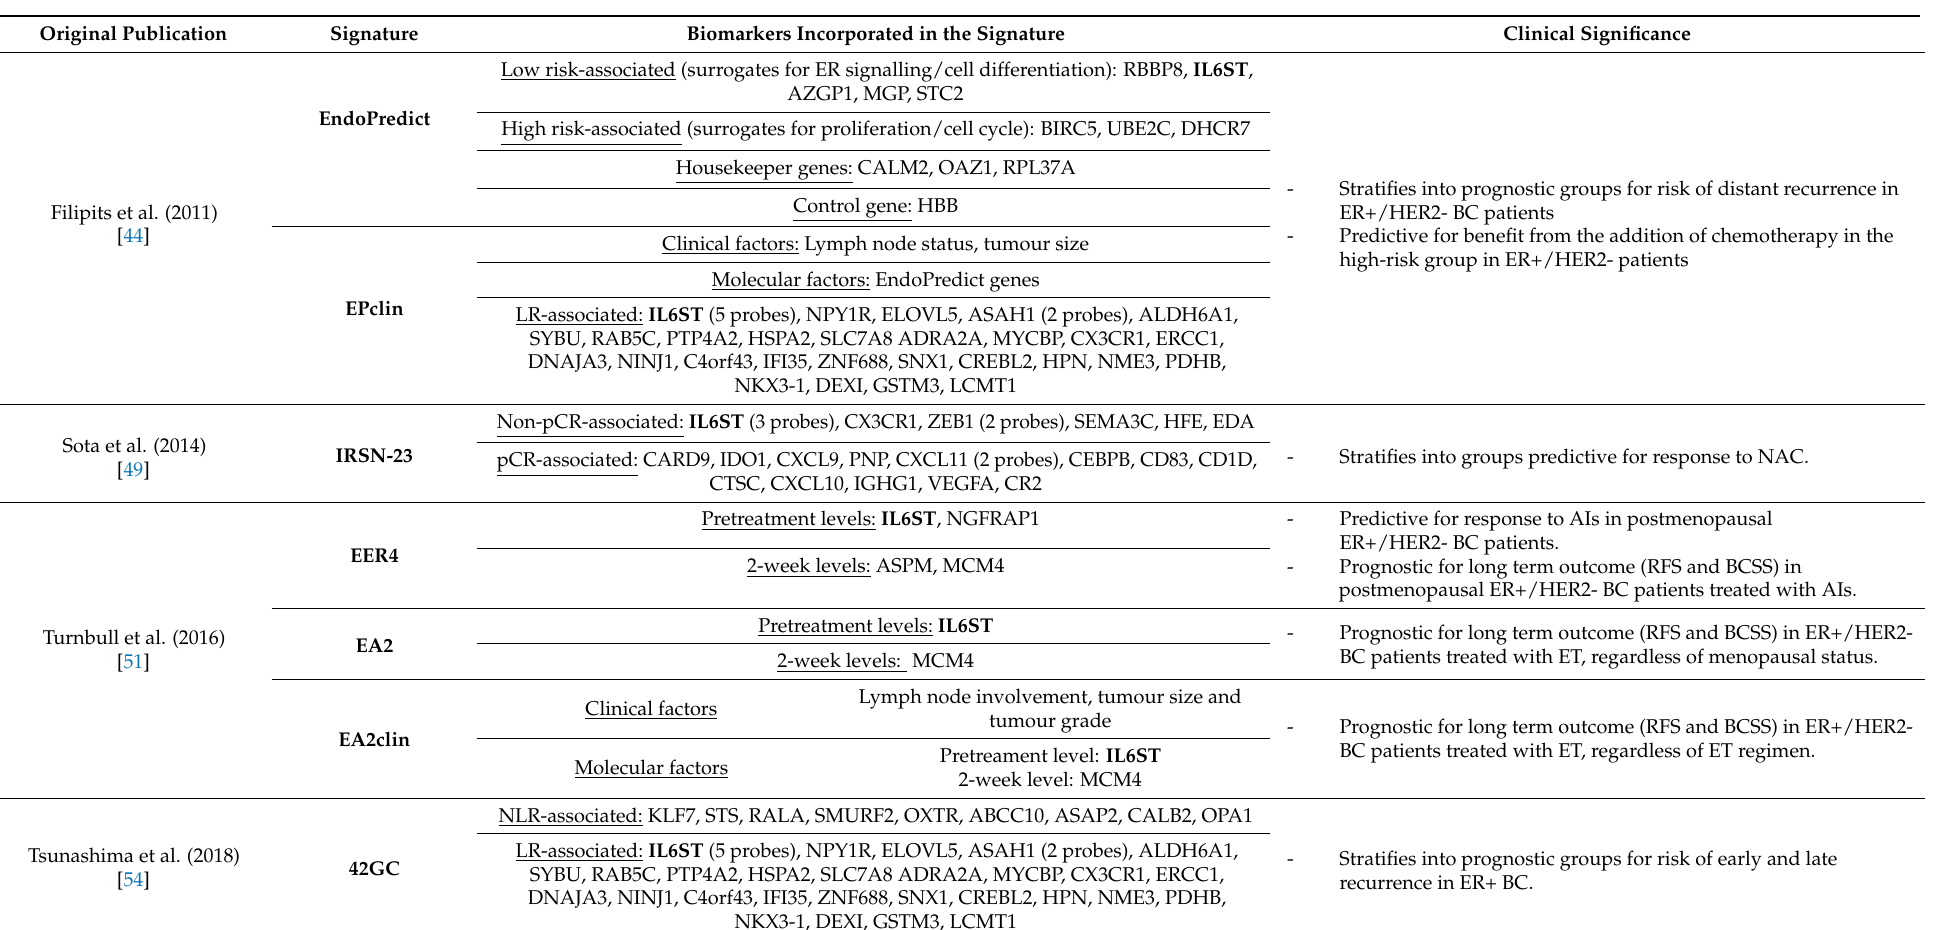
Table 2. Summary of molecular signatures incorporating IL6ST. The markers included in each model are listed, as well as its prognostic or predictive value. See Figures 2 and 3 for further description of the hybrid multifactor